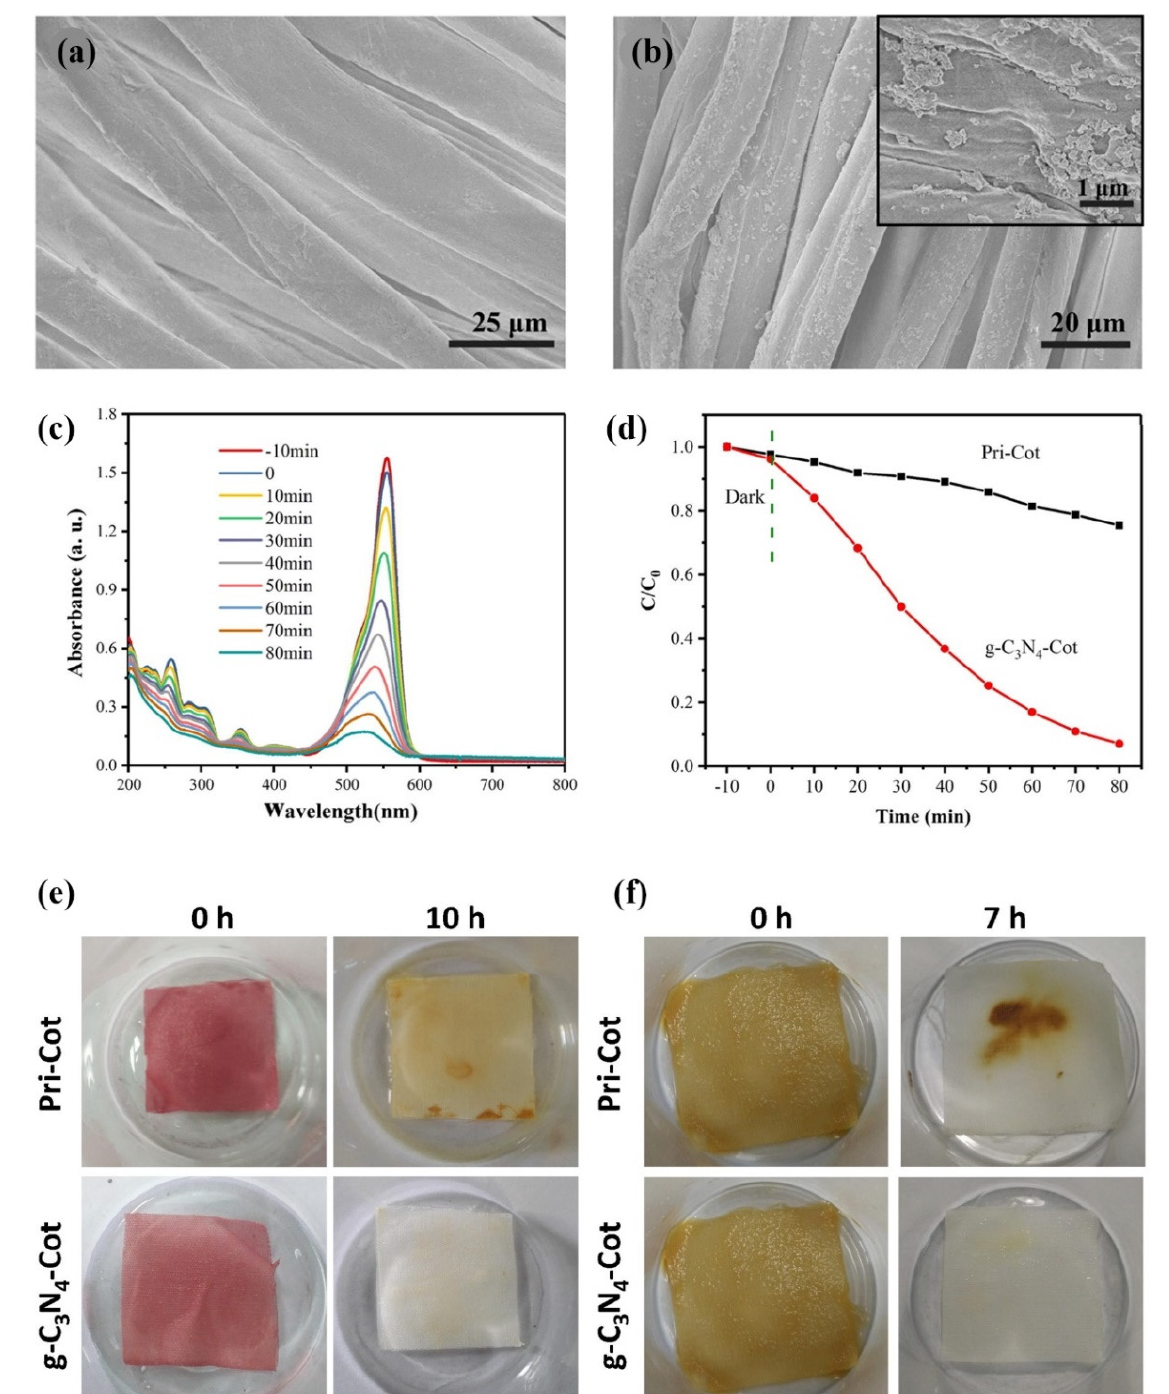
Figure 7. ( a , b ) SEM images of ( a ) untreated and ( b ) g-C 3 N 4 -coated cotton (insert—under higher magnification). ( c ) Evolution of UV–Vis absorption spectra of RhB solution with g-C 3 N 4 coated cotton. ( d ) Plots of C/C 0 of the RhB degradation versus time in the presence of uncoated pristine cotton (Pri-Cot) and g-C 3 N 4 coated cotton (g-C 3 N 4 -Cot). ( e – f ) Degradation of white cotton samples stained with red wine ( e ) after 10 h of light irradiation under a xenon lamp and of white cotton samples stained with coffee ( f ) after 7 h of light irradiation under a xenon lamp. Reprinted with permission from [43]. Copyright 2018, Elsevier.